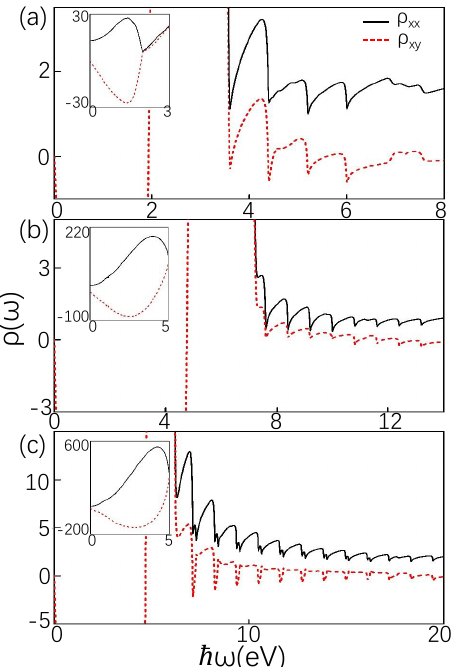
Figure 4. Resistivity in units of 2 π l B . ( a – c ) corresponds to ( a – c ) in Figure 3. The parameters are the same as in Figure